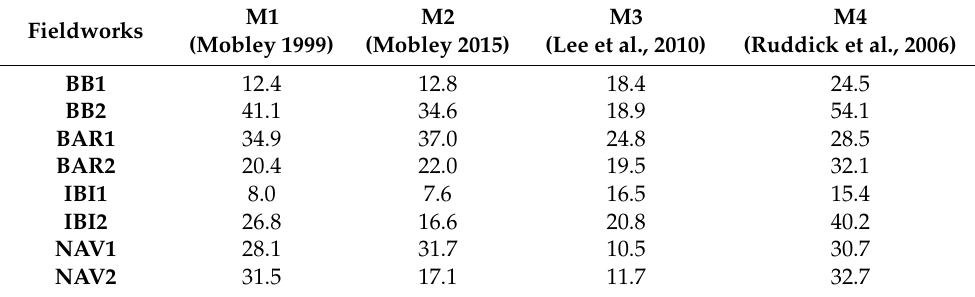
Table 5. nRMSDs (%) for in situ R rs retrieved from M1, M2, M3 and M4 methods using HydroLight R rs as reference data.